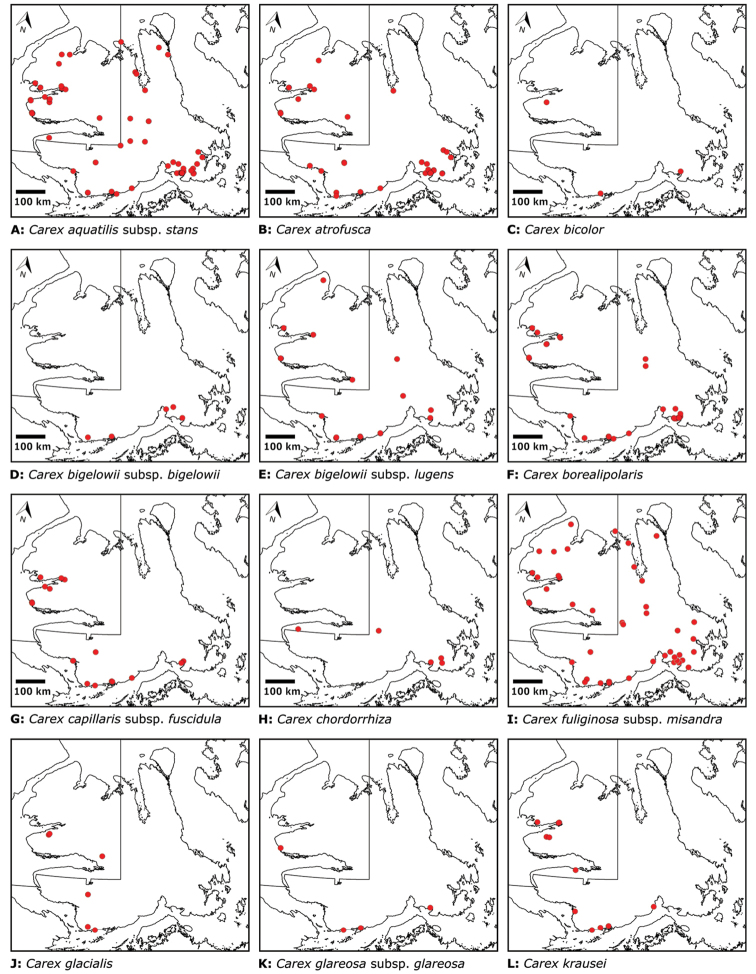
Species distribution maps. Cyperaceae: ACarex
aquatilis
subsp.
stansBCarex
atrofuscaCCarex
bicolorDCarex
bigelowii
subsp.
bigelowiiECarex
bigelowii
subsp.
lugensFCarex
borealipolarisGCarex
capillaris
subsp.
fuscidulaHCarex
chordorrhizaICarex
fuliginosa
subsp.
misandraJCarex
glacialisKCarex
glareosa
subsp.
glareosaLCarex
krausei.